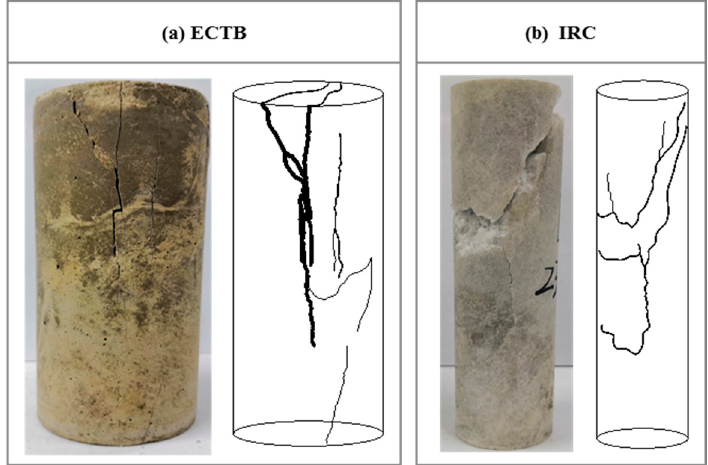
Figure 14. Failure mode of the ( a ) external cement-tailing backfill (ECTB) and the ( b ) inner rock core (IRC) under the TCS test. Sketches were drawn manually according to the real cracks.